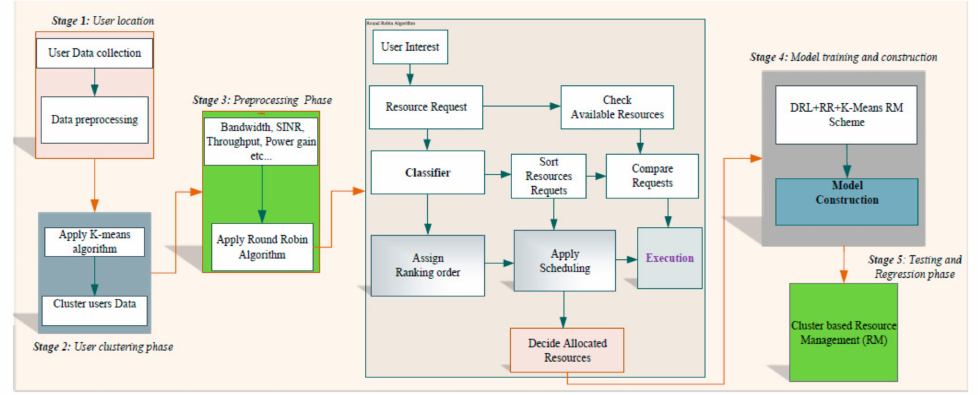
Figure 4. The flow chart of clustering, training and scheduling phases: DRL; deep reinforcement